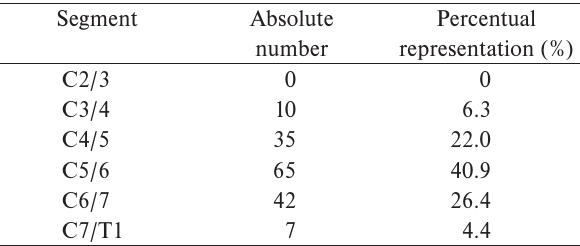
Table 1. Representation of treated motion segments in our patients’